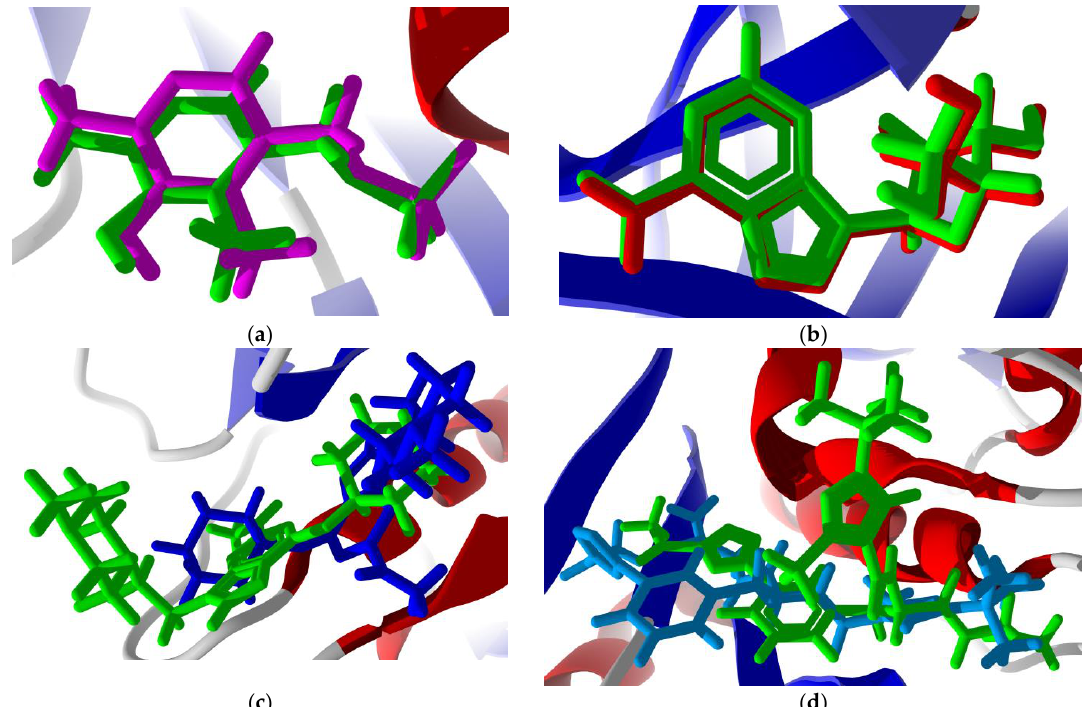
Figure 7. Lowest-energy re-docked poses of co-crystallized ligands: ( a ) Trichomonas vaginalis methionine gamma-lyase (TvMGL, PDB 1E5F [27]) showing the co-crystallized ligand, pyridoxal- 5′ - phosphate (green), and the re-docked ligand (magenta); ( b ) T. vaginalis purine nucleoside phosphorylase (TvPNP, PDB 1Z36 [28]) showing the co-crystallized ligand, (1 S )-1-(7-amino-1 H -pyrazolo[4,3-d]pyrimidin-3-yl)-1,4-anhydro- D -ribitol (green), and the re-docked ligand (red); ( c ) human cathepsin K (HsCatK, PDB 1U9V [38]) showing the co-crystallized ligand, 6-(cyclohexylamino)-9-[2-(4-methylpiperazin-1-yl)-ethyl]-9 H -purine-2-carbonitrile (green), and the re-docked ligand (blue); and ( d ) human cathepsin L (HsCatL, PDB 3HWN [39]) showing the co-crystallized ligand, N - α -[(3- t -Butyl-1-methyl-1 H -pyrazol-5-yl)carbonyl]- N -[(2 E )-2-iminoethyl]-3- {5-[( Z )-iminomethyl]-1,3,4-oxadiazol-2-yl}- L -phenylalaninamide (green), and the re-docked ligand (aqua).